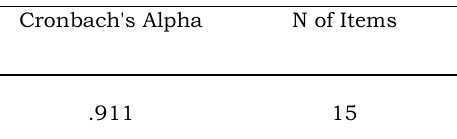
Table 3. Reliability of the